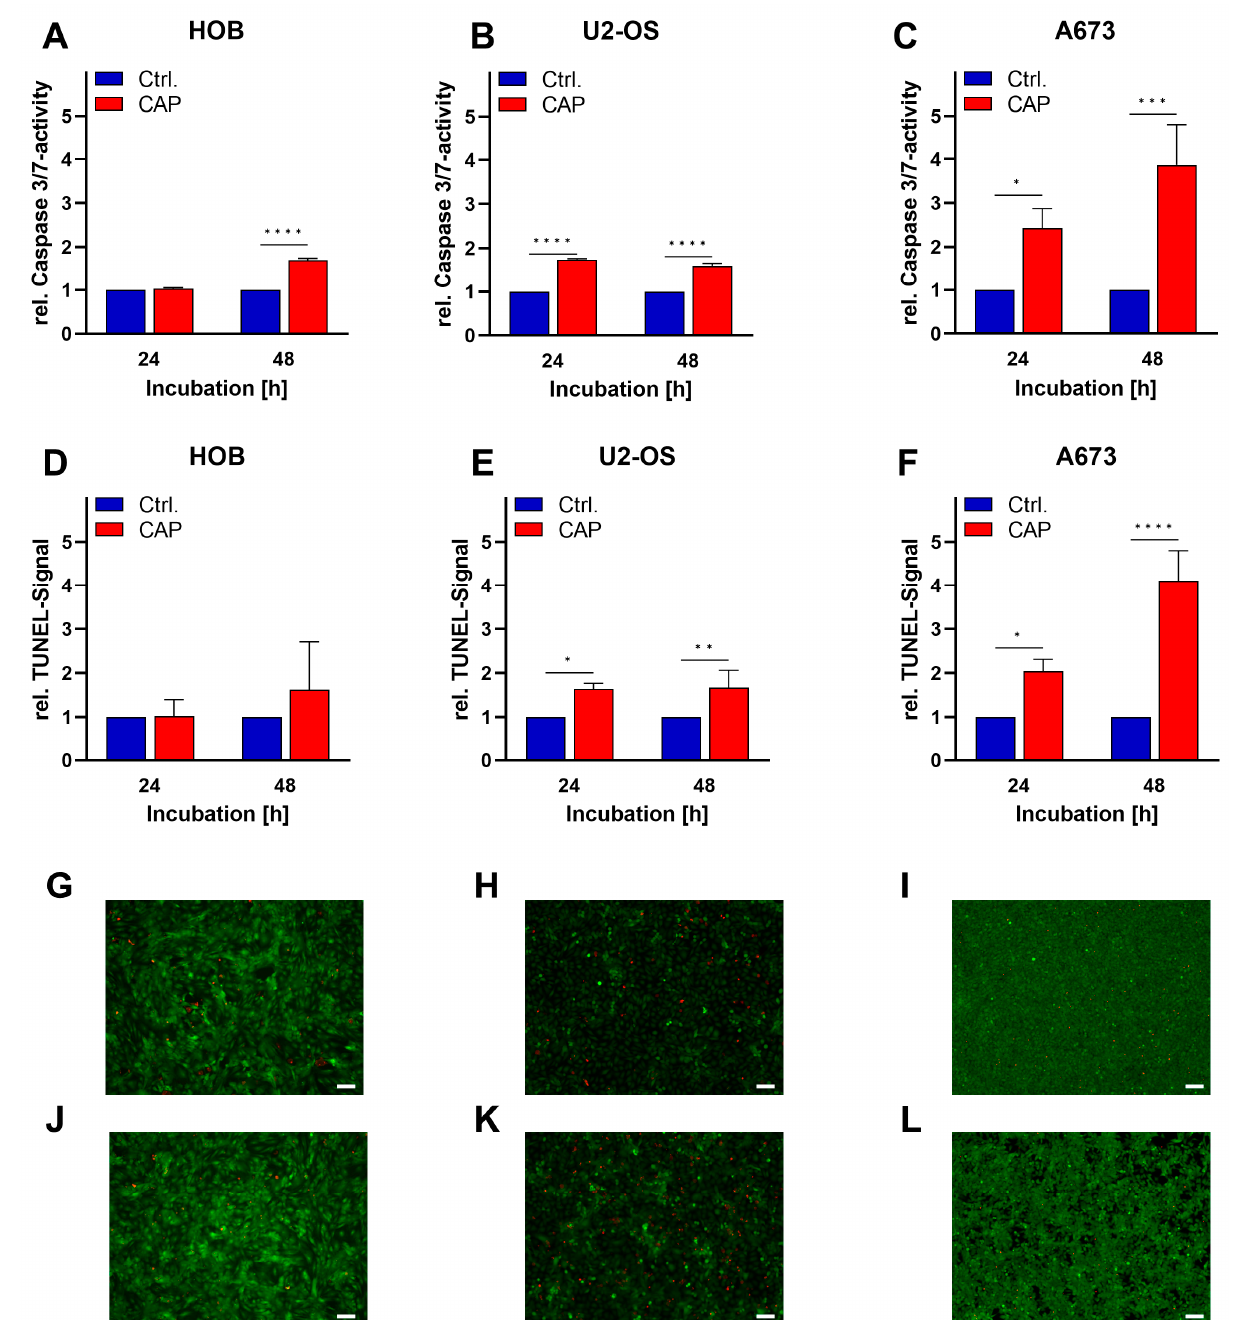
Figure 3. Human osteoblasts (HOB) and bone cancer cells (U2-OS and A673) were treated with cold atmospheric plasma (CAP) or argon for 10 s. After 24 h and 48 h, the apoptosis assays caspase-3/7 ( A – C ) and TUNEL ( D – F ) were performed. Cells were stained live (green)/dead (red) cell imaging kit ( G – L ), first row ( G – I ): argon treated, second row ( J – L ): CAP treated cells; representative images were shown. Data were given as mean ± SD of relative fluorescence ( A – C ) or absorption ( D – F ). Scale indicator is 100 µm. Significant differences are indicated as follows: * p < 0.05, ** p < 0.01, *** p < 0.001, **** p < 0.0001.